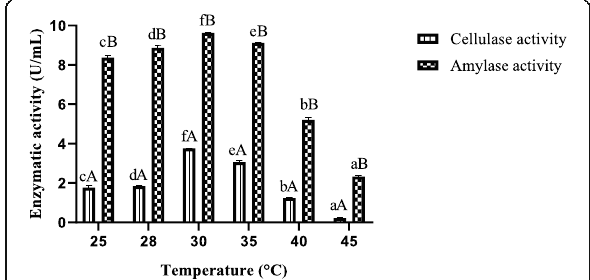
Fig. 3 Effect of incubation temperature on production of amylase and cellulase enzymes A. niger ASP2. Values are mean ± standard error of triplicates. a – f Means in same column of each parameter with different lower case letters differed significantly ( p < 0.05). A, B Values in the enzymatic activity (cellulase and amylase) for each parameter with different lower case letters differed significantly ( p < 0.05)